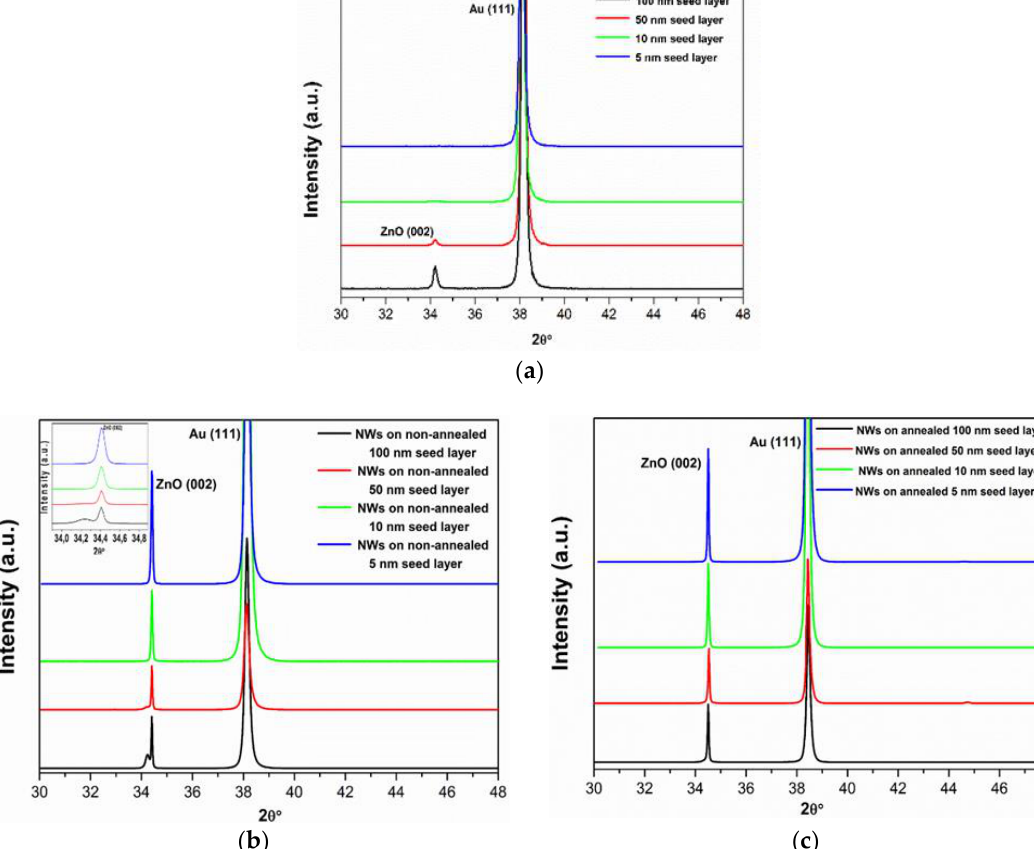
Figure 3. X-ray diffraction (XRD) spectra of ( a ) ZnO seed layer thin films with different thicknesses, ( b ) ZnO NWs grown on non-annealed (shown in the inset is (002) peak splitting) and ( c ) annealed ZnO seed layers with different thicknesses.